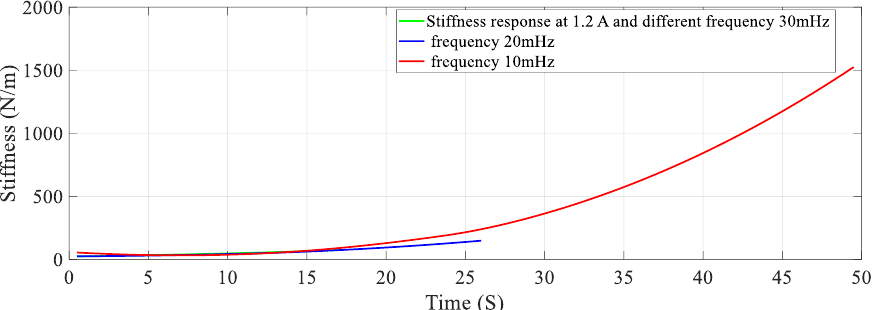
Figure 11. Effect of frequency on Stiffness of the Shape memory spring.